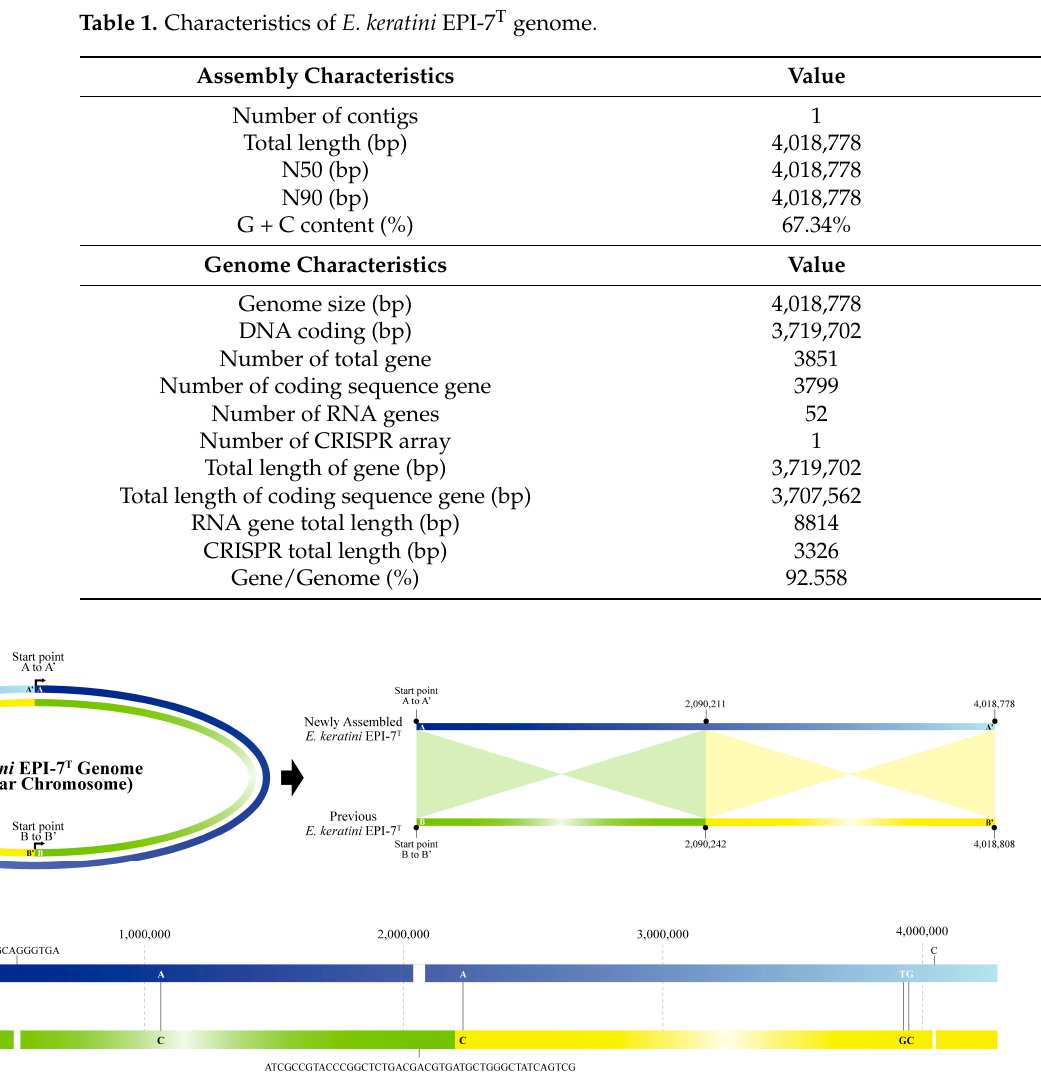
Figure 2. Representation of the newly-assembled and previous genome. A comparison between the newly-assembled genome and the previous genome was performed using Chromeister and the genome alignment (Mauve) services of PATRIC. In the case of the base sequence direction, when the newly-assembled genome of E. keratini EPI-7 T is expressed as a dark blue line to a light blue line (A to A ′ ), the genome sequence of the previous E. keratini EPI-7 T is expressed as a green line to a yellow line (B to B ′ ). It was found that the genome sequences were expressed in different orientation. Using the corrected E. keratini EPI-7 T genome, we were able to identify a total of 3851 genes, compared to the previous genome data. Among a total of annotated